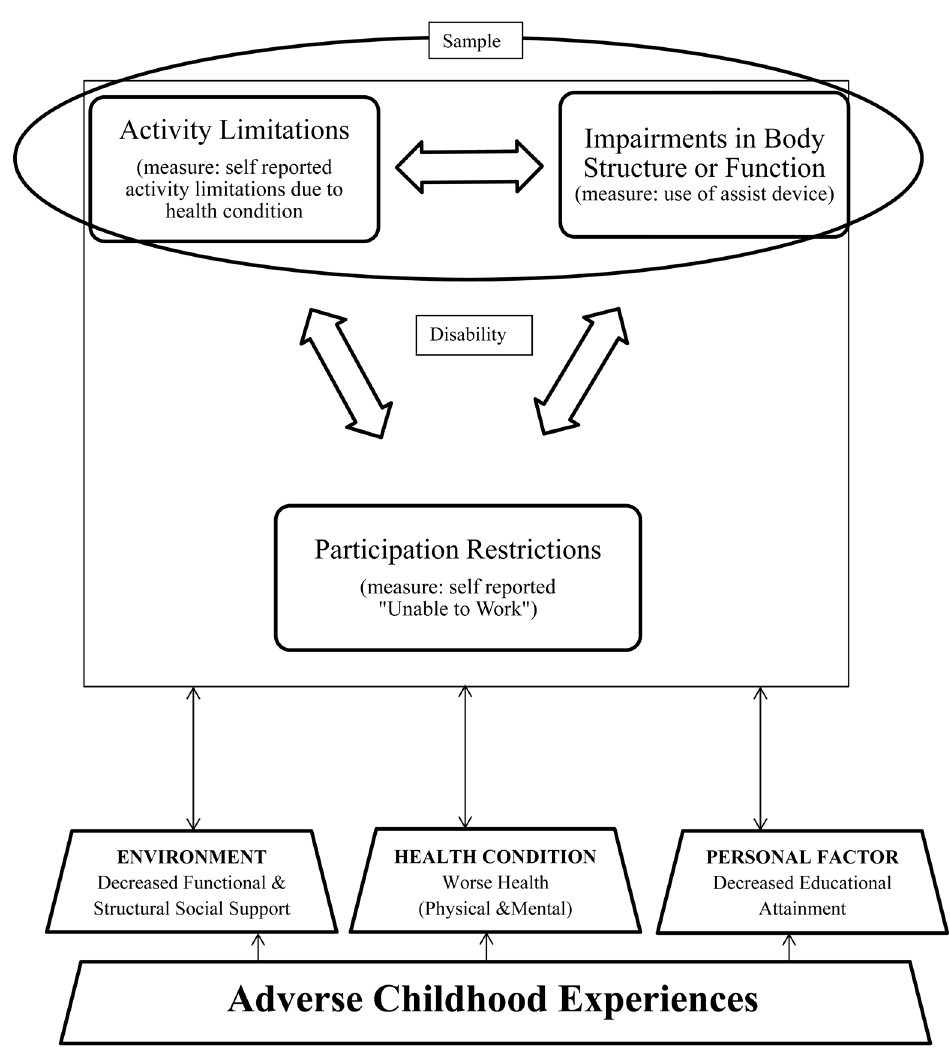
Fig 1. Conceptual